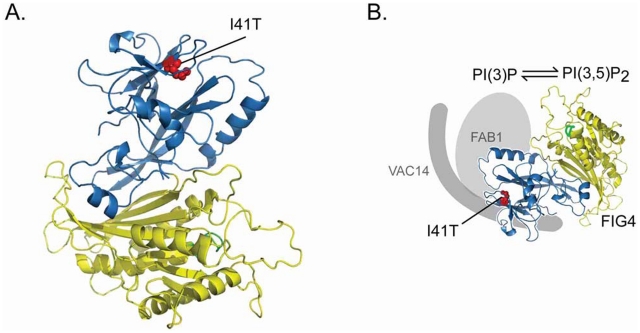
Location of the FIG4-I41T mutation and effect on protein interaction.A) Predicted structure for FIG4 phosphatase based on protein coordinates of yeast Sac1 phosphatase(18). The isoleucine residue mutated in CMT4J (red) is located near the surface of the N-terminal domain (blue) that is predicted to function in protein-protein interaction [18]. The catalytic domain (yellow) contains the active site (green). Image courtesy of Yuxin Mao. B) Predicted orientation of the FIG4 protein in the PI(3,5)P2 biosynthetic complex [3]. As shown in this paper, the I41T mutation of FIG4 (red) reduces interaction with both FAB1 and VAC14.